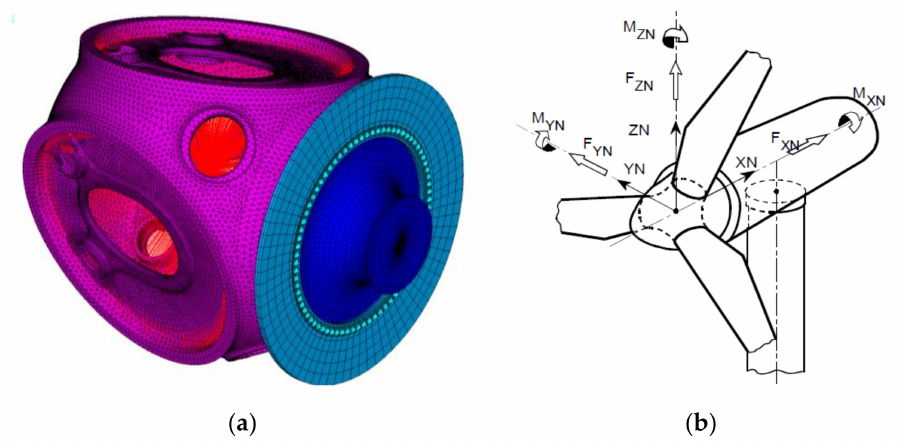
Figure 4. ( a ) FEA model of main shaft-to-hub bolted connection; ( b ) Hub coordinate